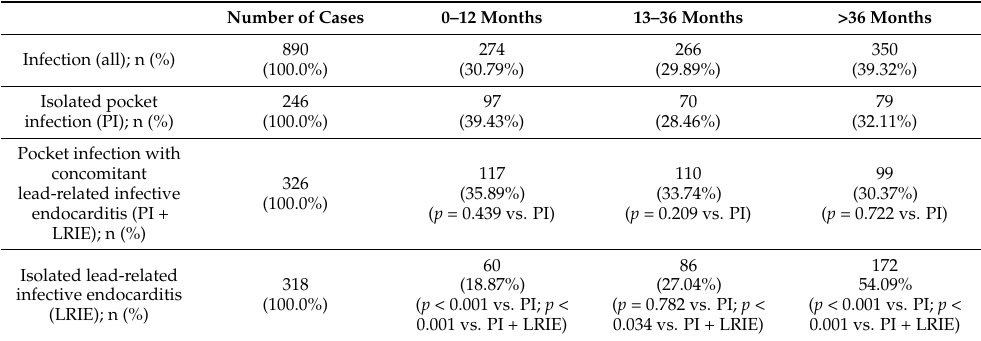
Table 1. Prevalence of CIED infections at each time interval after a CIED-related procedure for noninfectious